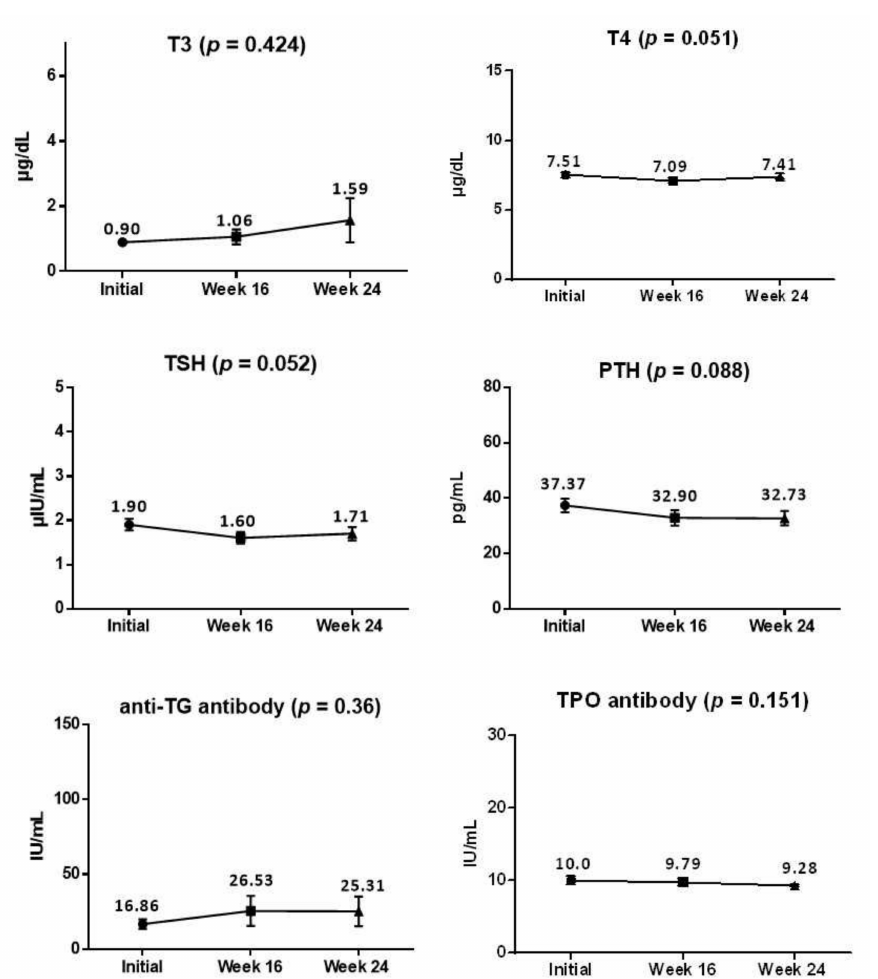
Figure 4. Changes in thyroid function tests during the study (data are shown as mean ± SEM). T3, triiodothyronine; T4, thyroxine; TSH, thyroid stimulating hormone; PTH, parathyroid hormone; anti-TG, anti-thyroglobulin; anti-TPO, anti-thyroid